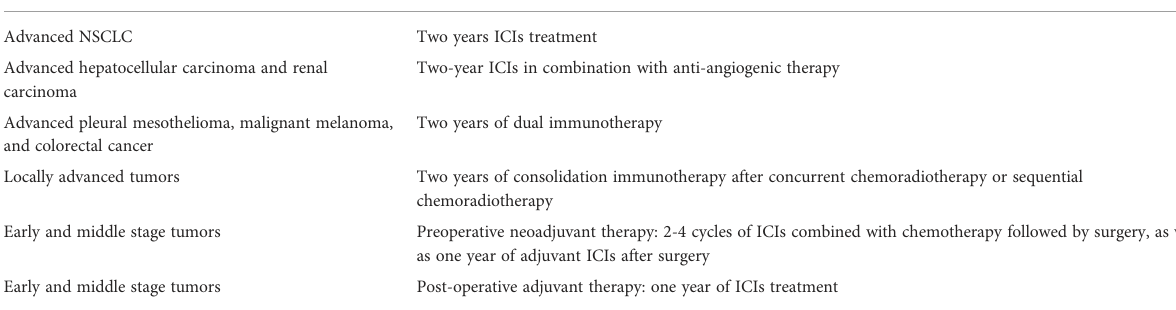
TABLE 1 Duration of ICIs for different tumors and